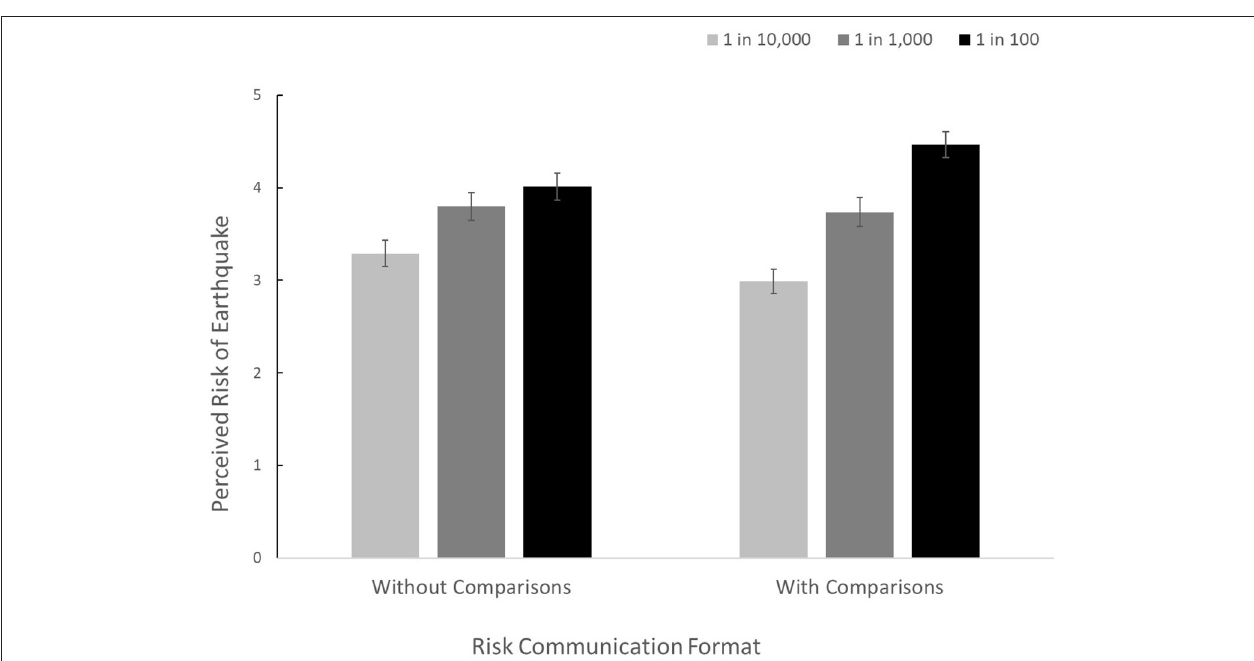
FIGURE 1 | Mean perceived risk of earthquake as a function of the level of probability and the risk communication format.